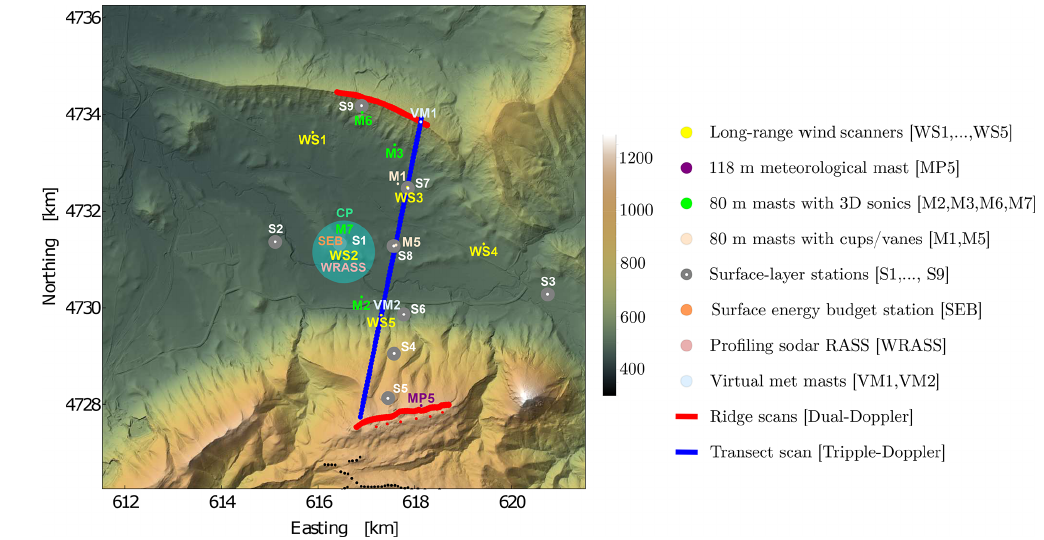
Figure 3. Instrumentation layout of the ALEX17 campaign within the 10km × 10km experimental domain centered at CP. The legend details each type of measurement station. The transect scan (blue line), detailed in Fig. 4, is the focus of this